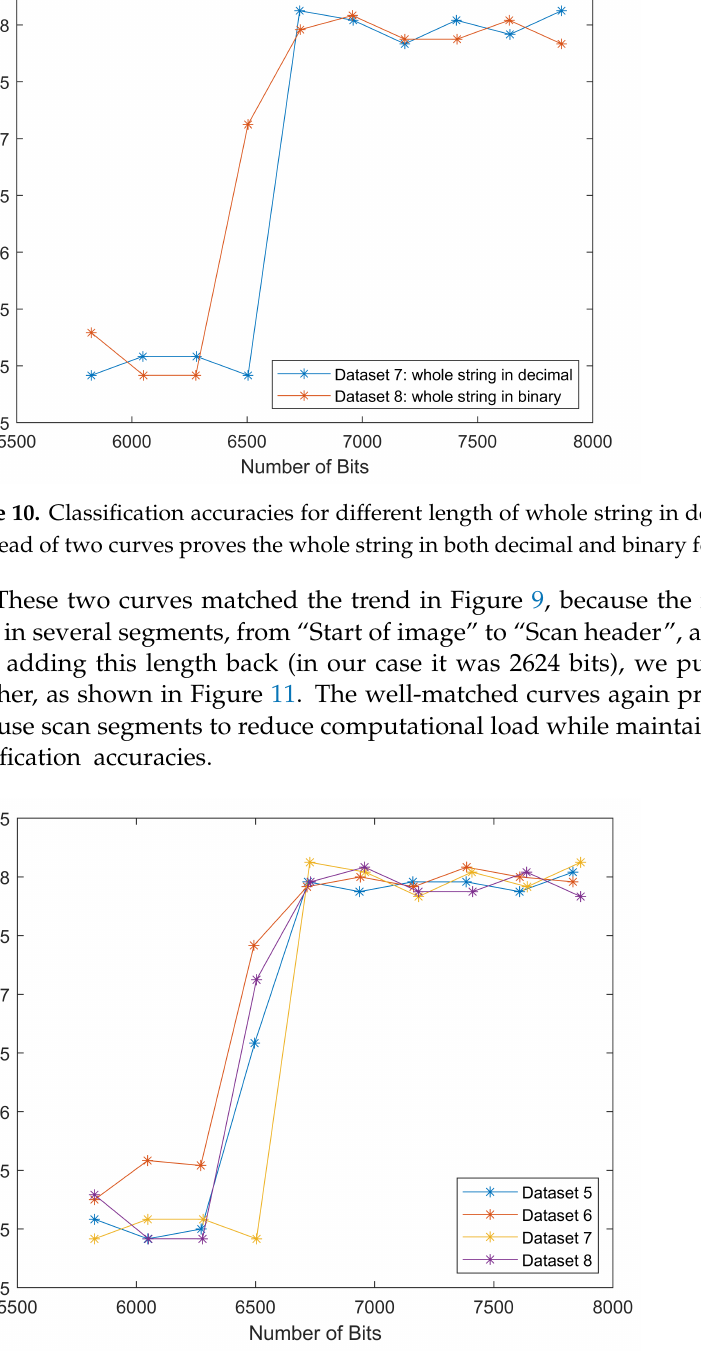
Figure 11. Classification accuracies for datasets five to eight. The similar shape of the four curves proves that the LSTM model can successfully classify compressed domain